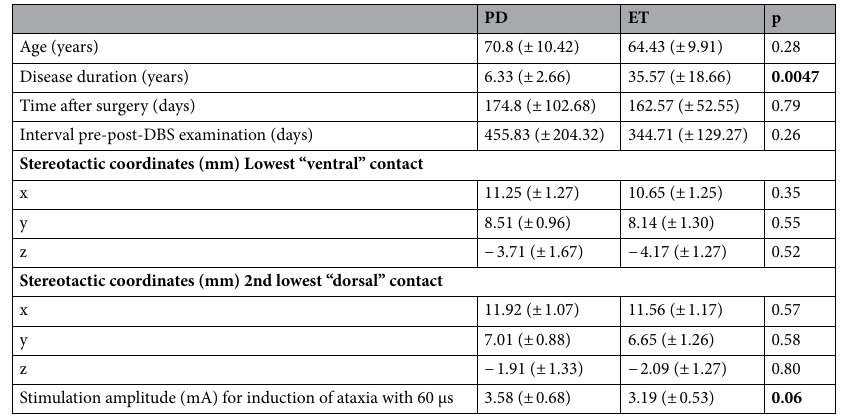
Table 2. Group characteristics of PD and ET patients. Significant values are in bold. “Disease duration” (years) is calculated from symptom onset to the study assessment. “Time after surgery” (days) is calculated from the date of surgery to the study assessment. “Interval pre-post-DBS examination” (days) is calculated from the date of the pre-operative evaluation to the study assessment. “Stereotactic coordinates” (mm) are the coordinates of the “ventral” lowest and “dorsal” 2nd lowest contacts with x = lateral to midline, y = posterior to mid-commissural point (MCP), z = above the plane between anterior and posterior commissure. “Stimulation amplitude” (mA) is the suprathreshold amplitude to induce ataxia with 60 µs pulse width in ring